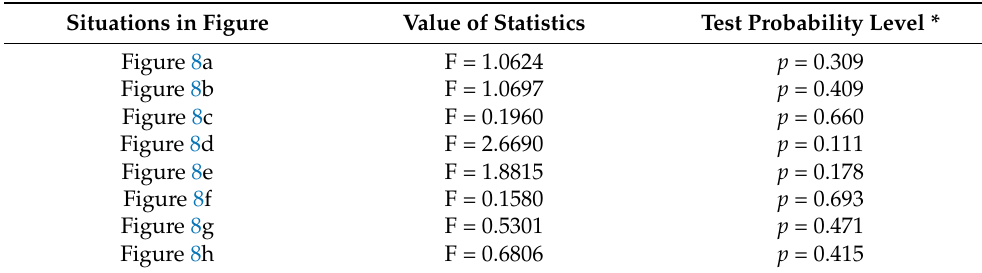
Table 9. Analysis of statistical hypotheses.